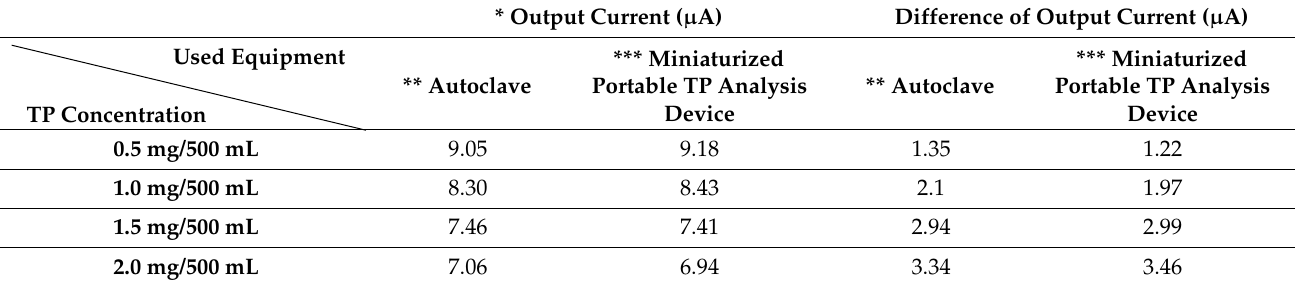
Table 3. Comparison of the autoclave and the miniaturized TP analysis system (pretreatment conditions: 100 mA UV LED array operating current and 15 min pretreatment time). The difference of the output current was calculated by differencing the output current between the DI (without phosphorus) and the analytes (with phosphorus).